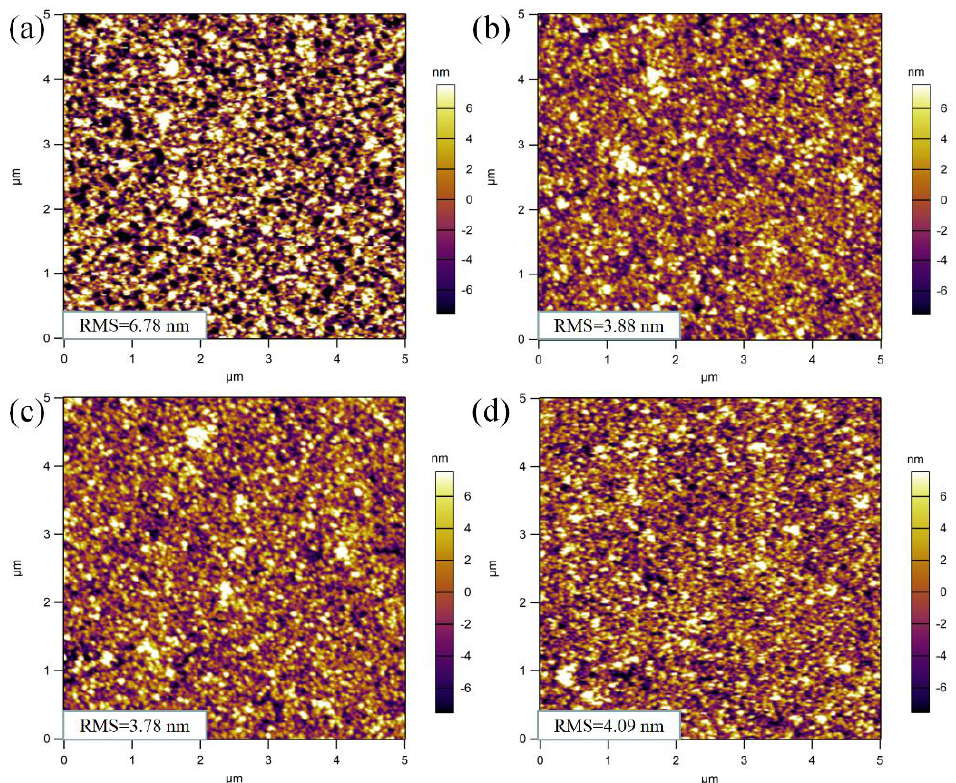
Figure 3. The AFM images of the films ( a ) one drop, ( b ) two drops, ( c ) three drops, and ( d ) four drops formed by dynamic drop − coating of the FAPb 0.7 Sn 0.3 Br 3 nanocrystalline